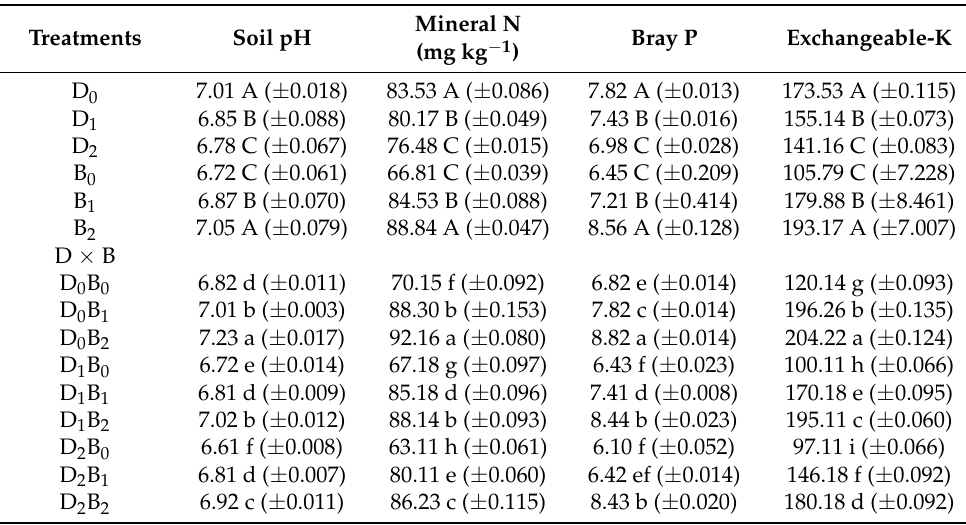
The different letter shows a significant difference in treatments at 5% probability level. D 0 = Control, D 1 = Drought at tillering stage, D 2 = Drought at grain filling, B 0 = (No-Biochar), B 1 = 28 g kg − 1 Biochar, B 2 = 38 g kg − 1 Biochar. Values in brackets are standard error of the mean ( n = 4).